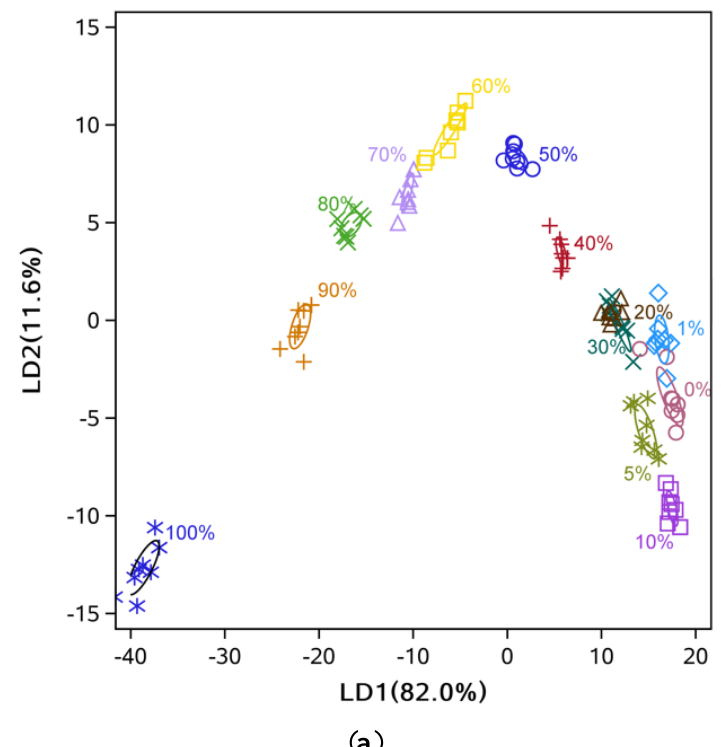
Figure 5. LD1 and LD2 score plot from LDA analysis. ( a ) Hot-pressed sesame oil mixed with refined soybean oil; ( b ) Cold-pressed sesame oil mixed with refined soybean